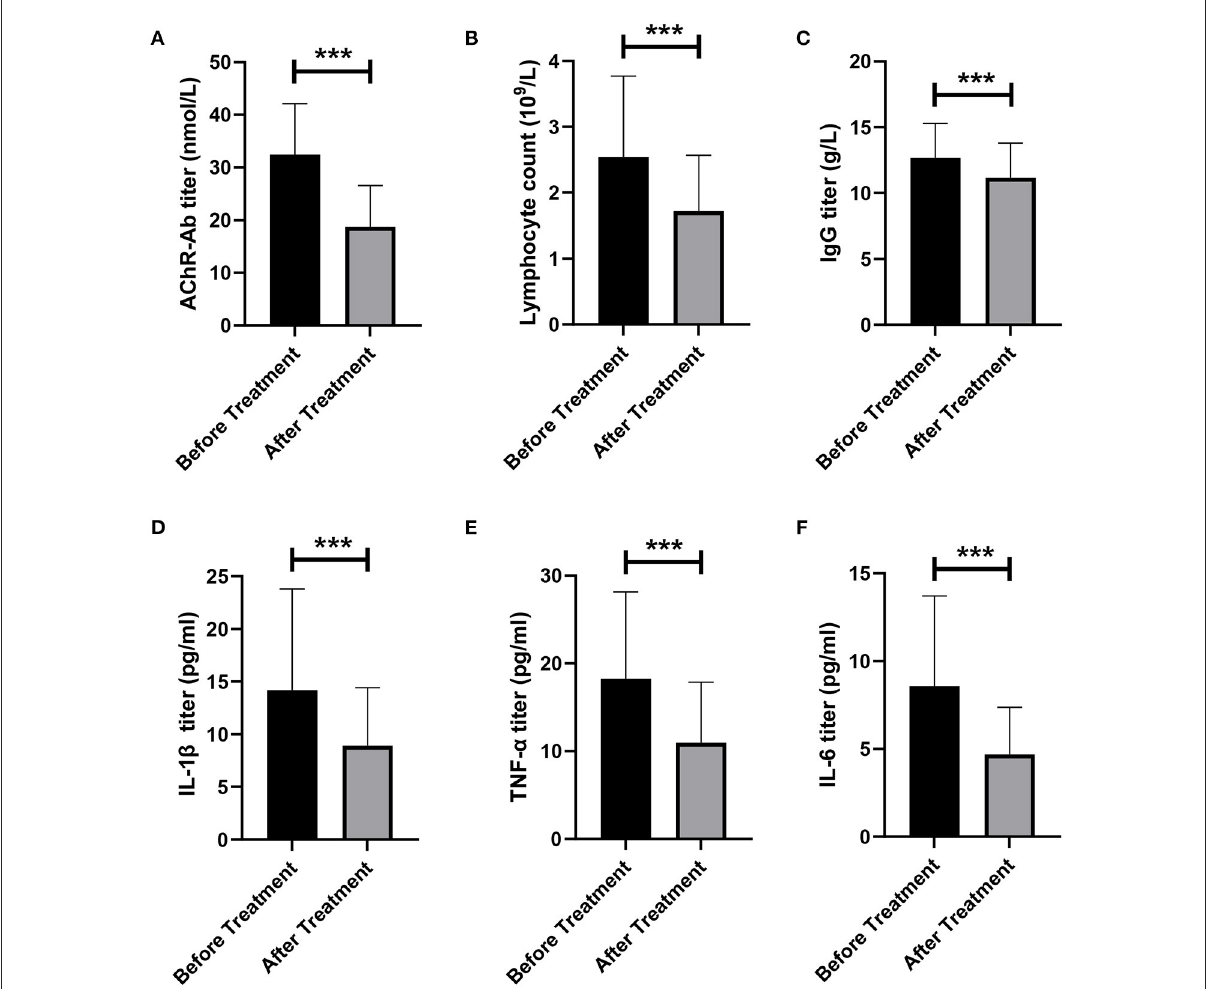
FIGURE3 Changes of immune indexes before and after treatment. (A) Changes of AChR-Ab titer before and after treatment. (B) Changes in the number of lymphocytes before and after treatment. (C) Changes in IgG titer before and after treatment. (D–F) Changes of proinflammatory factors IL-1 β (D) , TNF- α (E) , and IL-6 (F) before and after treatment. *** p < 0.001.